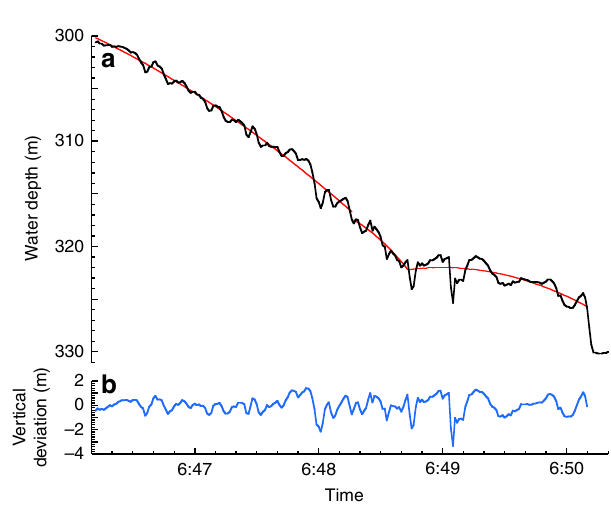
Fig. 7 Movement of massive 800 kg frame down canyon during the 24 November 2016 event. a Black line shows depth (converted from pressure) vs. time from BED 11 which was attached to the 800 kg frame (AMT/BED11; Fig. 4) during the 24 November 2016 event. Red line segments are polynomial fi ts to three sections of these data. BED 11 traveled at an average speed of 4 m s − 1 . b Deviations (blue line) of BED 11 trajectory ( a : black line) from the fi tted polynomials ( a : red line) show vertical oscillations between 1 – 3